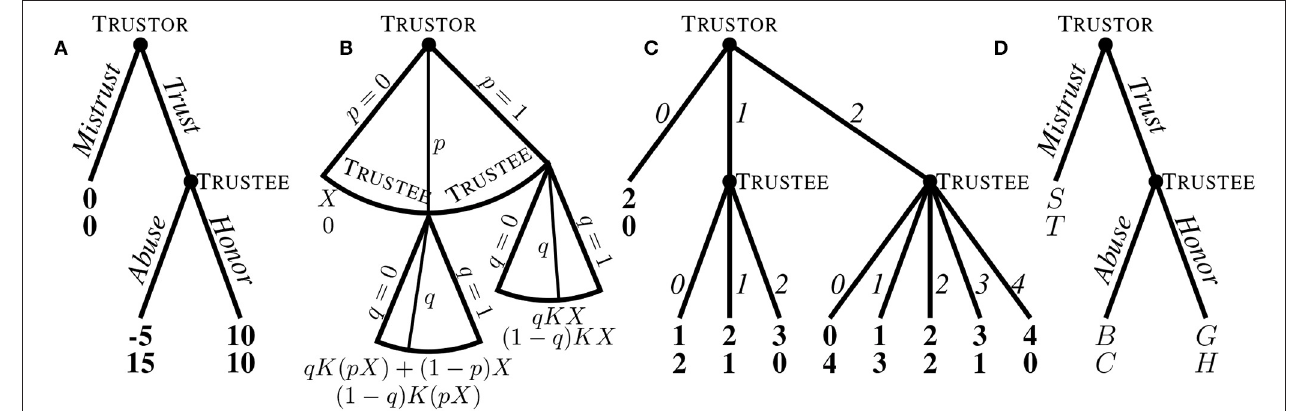
FIGURE 1 | (A) The original Trust Game of Kreps (1990), where both trustor and trustee have just binary choices. (B) A qualitative depiction of the infinite game representing the continuous version of the Trust Game of Berg et al. (1995), as envisioned in experimental economics. The trustor is endowed with $X and can send any proportion p ∈ [0,1]. The transfer pX is multiplied by a factor K > 1. The trustee receives K ( pX ) and can send back any proportion thereof, q ∈ [0,1]. The trustee has a continuum of possible, alternative decision nodes, corresponding to all possible transfers by the trustor. (C) A discretized version of the Trust Game. The trustor is endowed with X = 2 and transfers are doubled ( K = 2). Both trustor and trustee can only send integer amounts. (D) A heavily-discretized “mini-Trust Game,” as used, e.g., in Bohnet and Zeckhauser (2004). In all games, the upper payoff is the trustor’s and the lower payoff is the